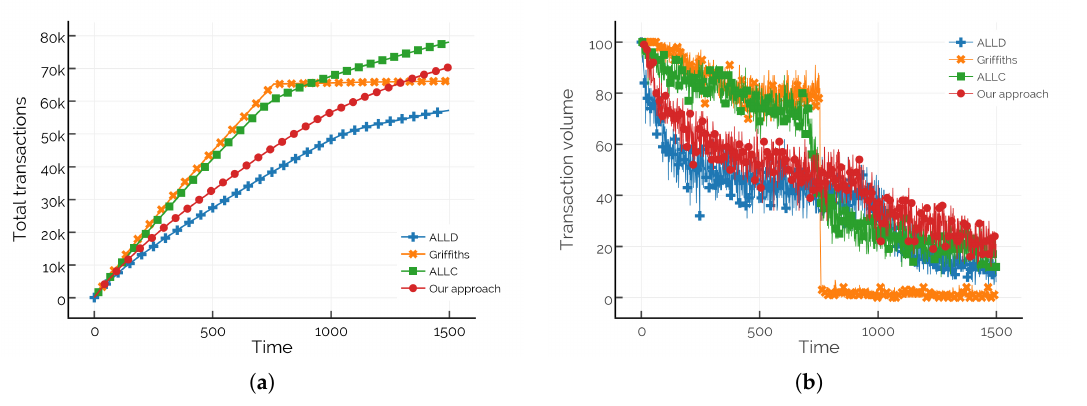
Figure 5. ( a ) Total transactions; ( b ) Transactions volumes at different time periods.